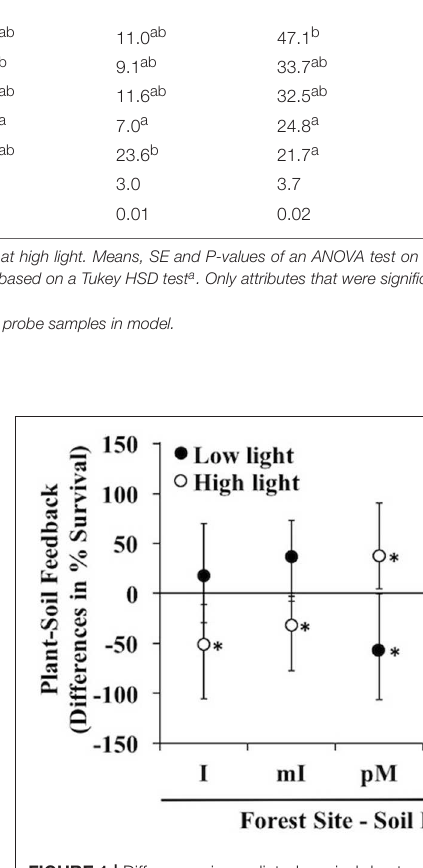
intermediate fertility site and a positive PSF at the highest fertility site (lowest C:N ratio). In low fertility sites at high light, Prunus serotina seedlings experienced a microbe-mediated negative feedback (i.e., the negative effect of conspecific vs. heterospecific soil was greater in non-sterile than sterile soil). In contrast in high fertility sites at high light, the feedback flipped to positive ( Figure 1 ). In low light, seedlings showed a negative feedback at a moderate fertility site (poor Moraine) and positive feedback at higher fertility (Moraine) ( Figure 1 ). The above microbe-mediated PSF values remove abiotic effects of the soil (survival response to sterile soils cultured by conspecific vs. heterospecific adult trees). In the non-sterile